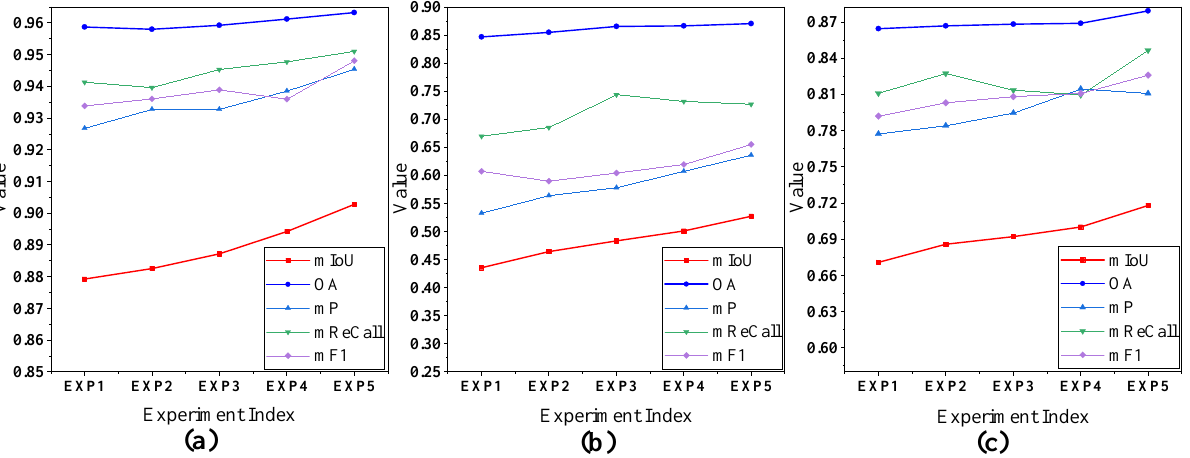
Figure 4. Line charts of the quantitative results in the ablation experiments of architecture on: ( a ) LandCover.ai, ( b ) DSTL, ( c ) DeepGlobe datasets.